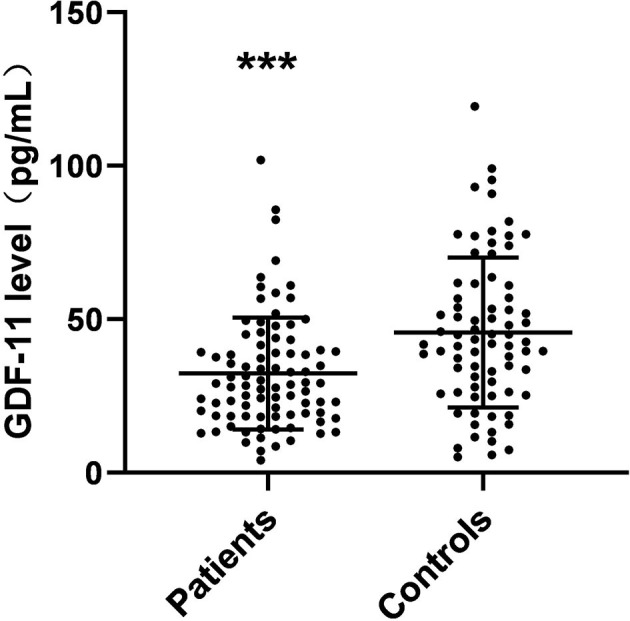
Scattergrams of plasma GDF-11 levels from patients with schizophrenia (n = 87) and from normal control subjects (n = 76). The sample means are indicated by the black bars. ***p < 0.001.